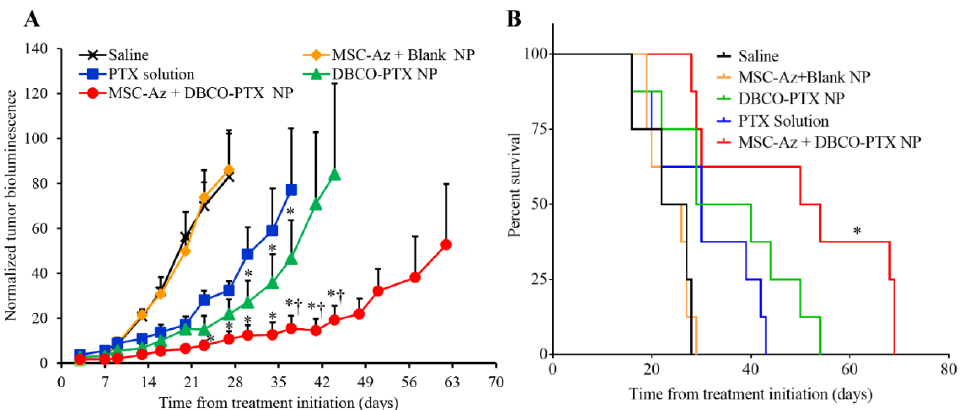
Figure 3. Antitumor e ffi cacy of two-step targeting strategy using glycoengineered MSCs. Mice bearing orthotopic C200-Luc ovarian tumors were intraperitoneally injected with saline; 1 × 10 6 MSC-Az followed by intraperitoneal injection of DBCO NP (MSC-Az + Blank NP); PTX solution (10 mg / kg, PTX solution); PTX-loaded DBCO NP (equivalent to 10 mg / kg PTX, DBCO-PTX NP); or 1 × 10 6 MSC-Az followed by intraperitoneal injection of DBCO-PTX NP (equivalent to 10 mg / kg PTX, MSC-Az + DBCO-PTX NP). All animals received respective treatments every 14 d. ( A ) Plot of normalized bioluminescence readings ( ± SEM; n = 8). (*) Indicates significantly di ff erent ( p < 0.05) from PTX solution; † indicates significantly di ff erent ( p < 0.05) from DBCO-PTX NP. ( B ) Kaplan-Meier survival curves for the di ff erent treatment groups. Log rank test of MSC-Az + DBCO-PTX NP and control groups yields p < 0.0001